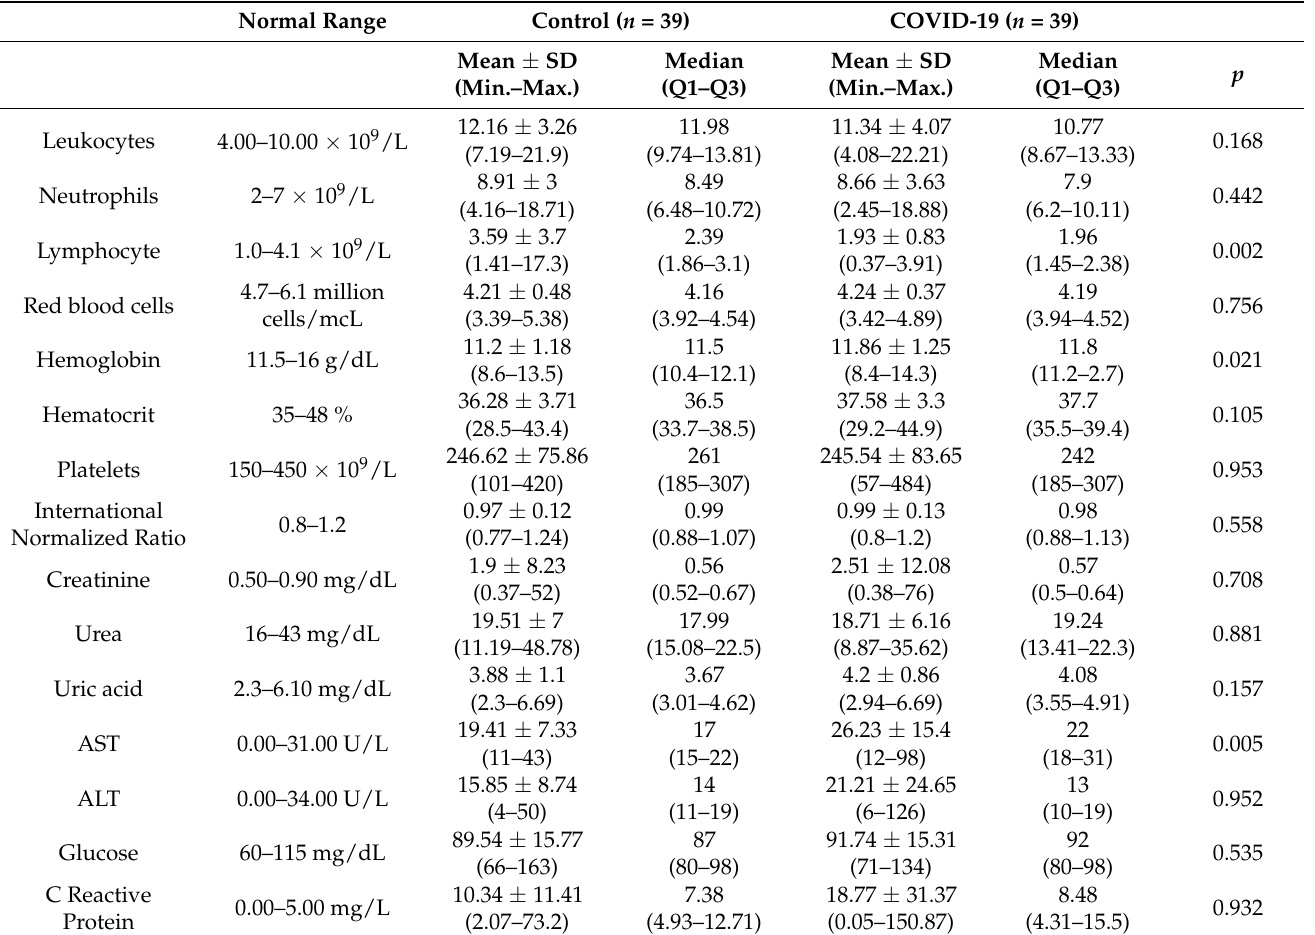
Table 2. Comparison of the blood parameters according to